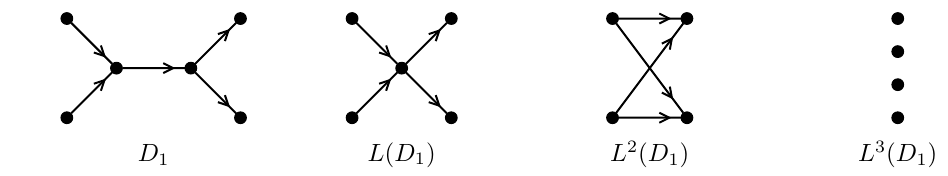
Figure 11: An example of line iterates of a digraph without